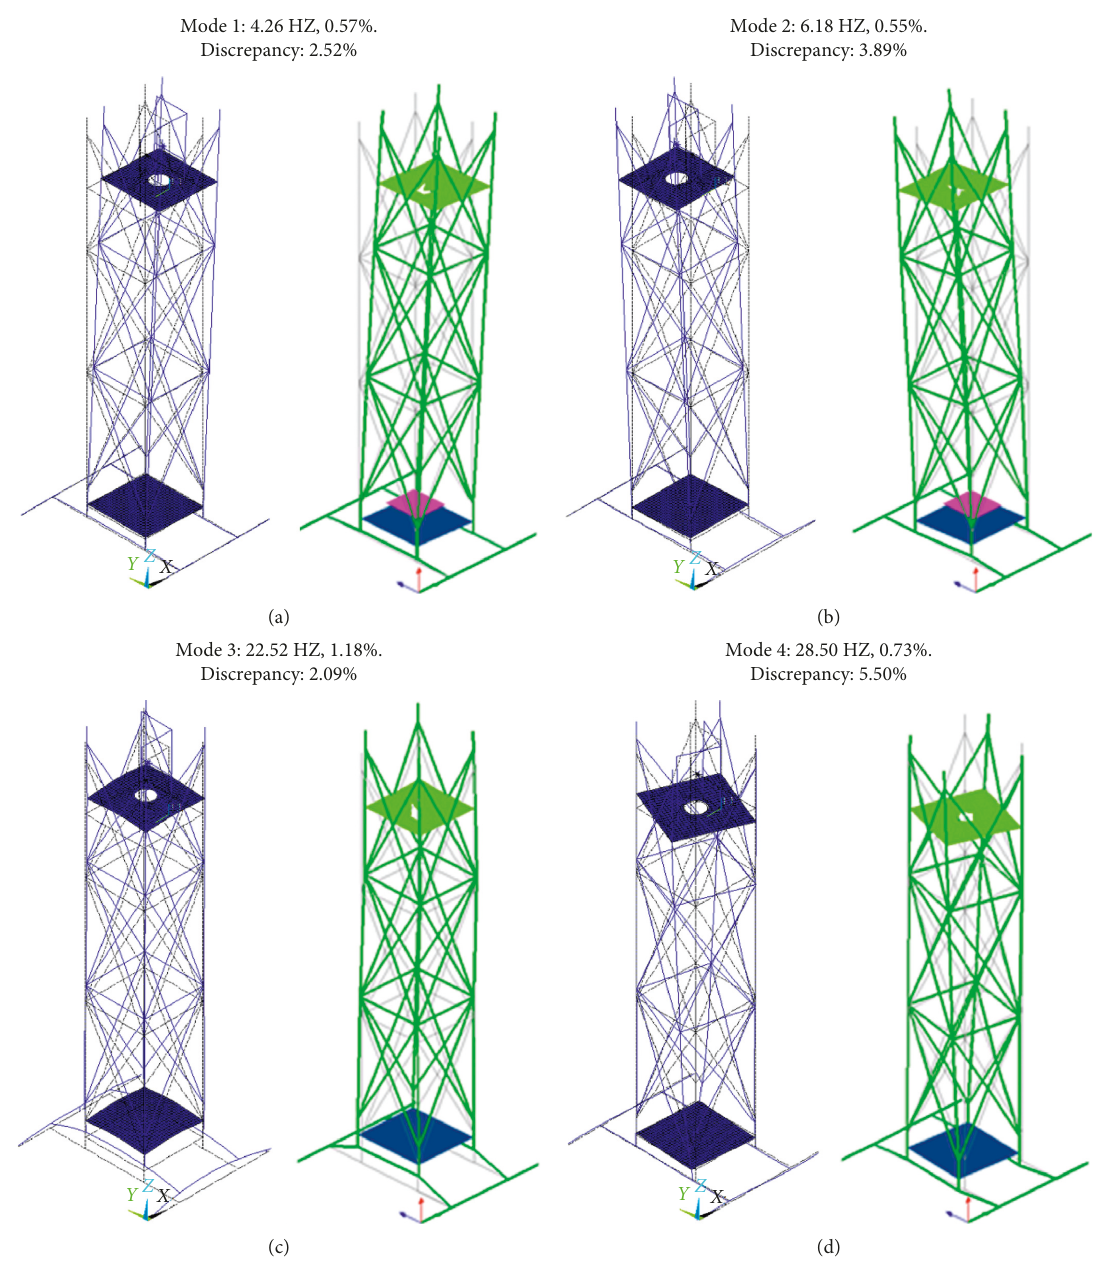
Figure 10: The first 4 paired modes. Frequency, damping, and discrepancy between the model (a, c) and the experimental results (b,